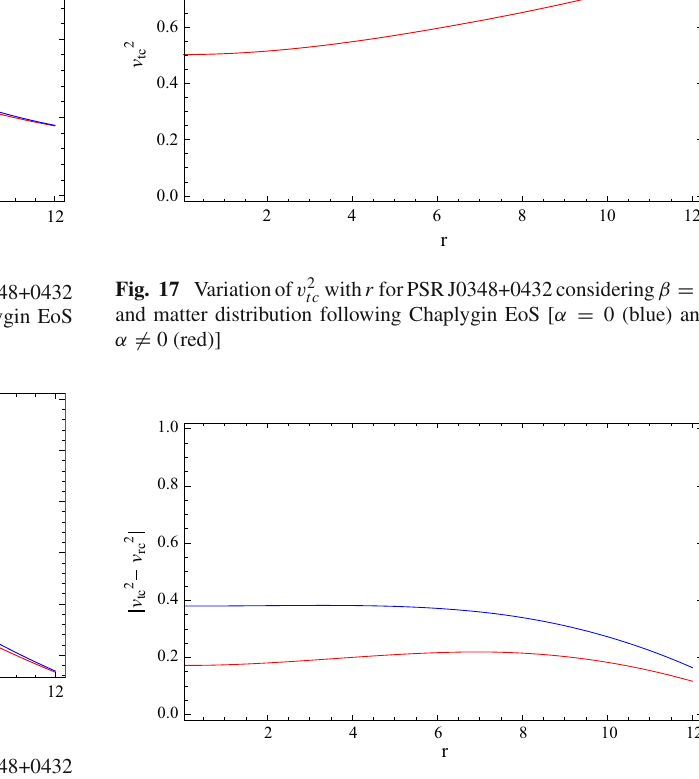
Fig. 18 Variationof | v 2 tc − v 2 rc | with r forPSRJ0348+0432considering β = 1 and matter distribution following Chaplygin EoS [ α = 0 (blue) and α (cid:5)= 0 (red)]